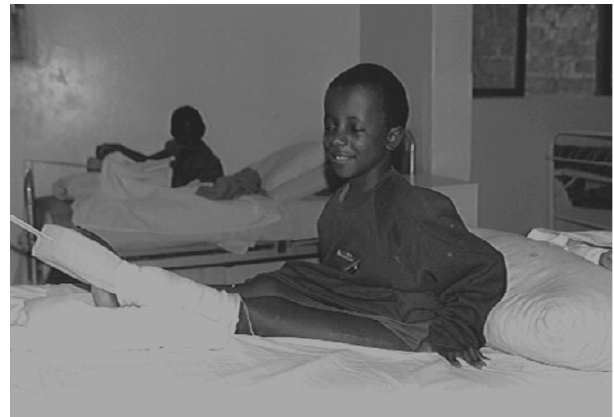
Figure 2 Musculo-skeletal abnormalities such as osteogenesis imper- fecta need extensive operative and conservative